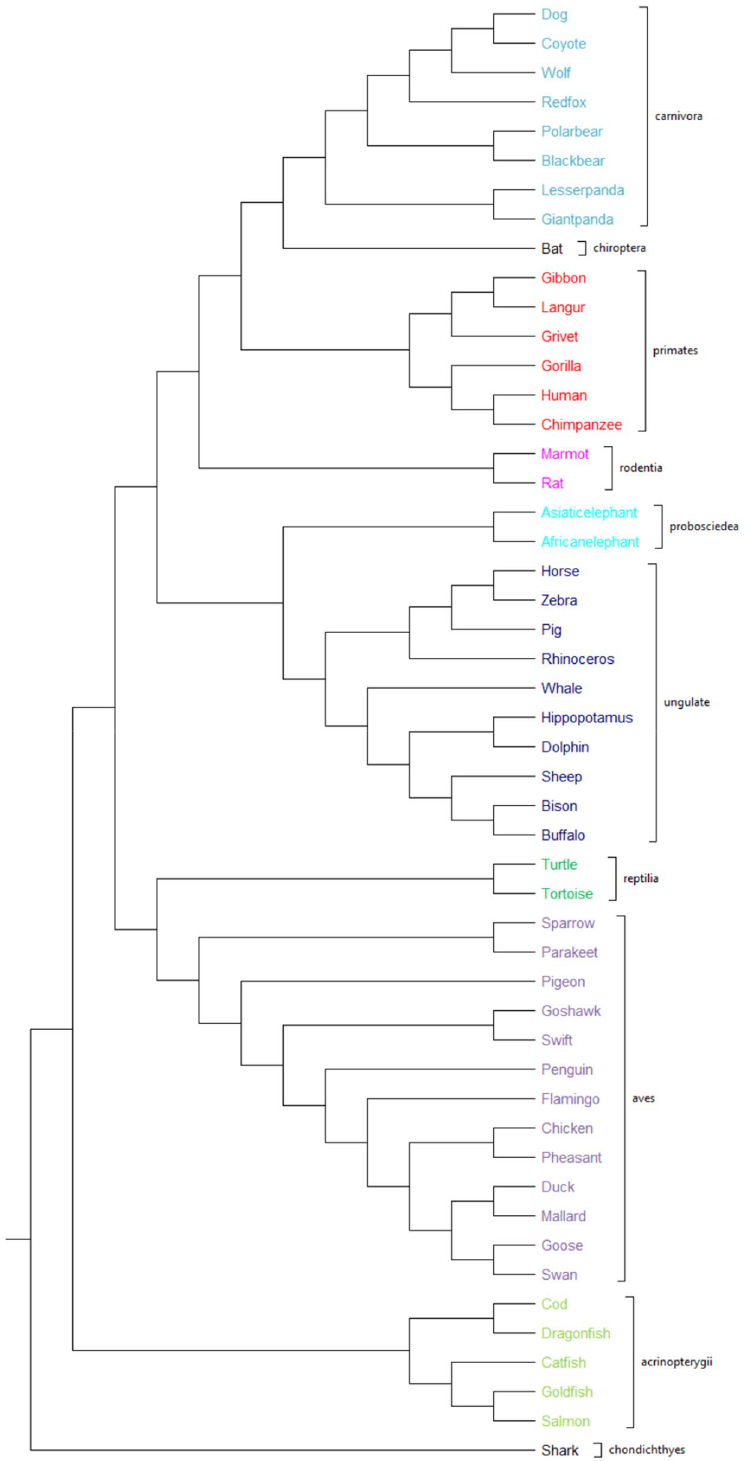
Figure 14. The phylogenetic tree of 50 betaglobin proteins constructed by our method